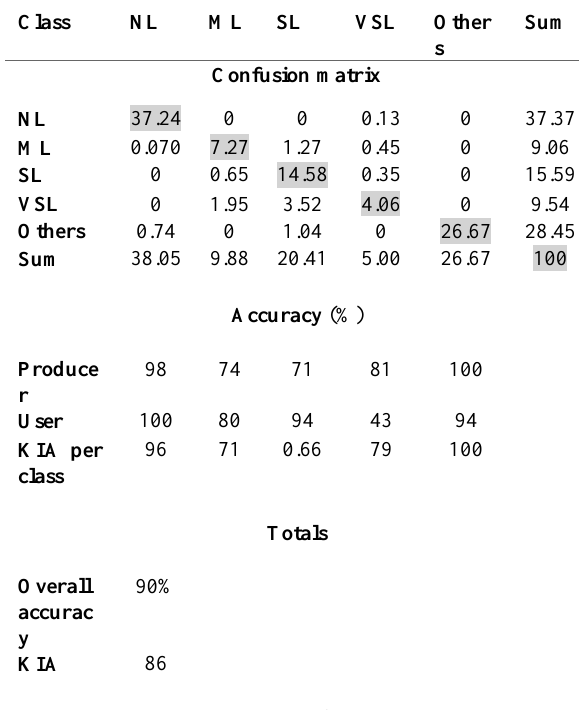
Table 2. Error matrix for the test